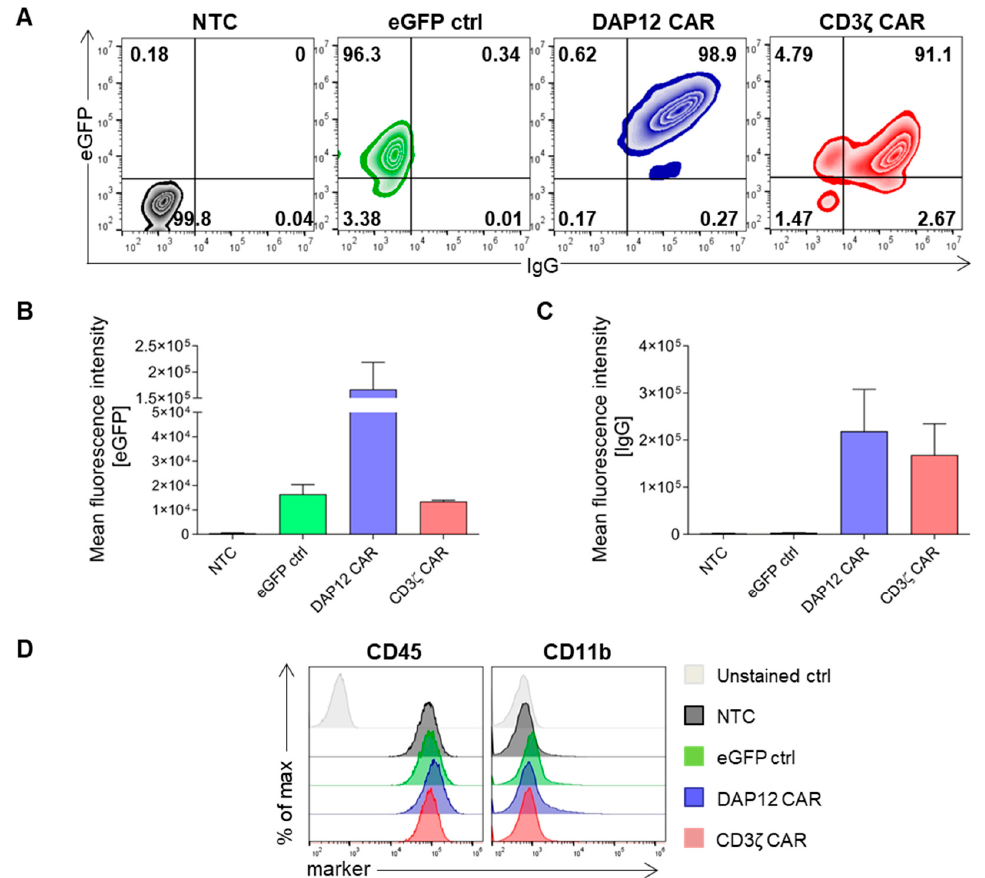
Figure A1. Assessment of CAR expression and characterization in MONO-MAC-6 cells. ( A ) Representative flow cytometric analyses of eGFP and CAR expression in MONO-MAC-6 cells transduced with eGFP alone (eGFP ctrl), the DAP12 CAR construct, or the CD3 ζ CAR construct. Mock-transduced cells (mock) were used as additional controls. Mean fluorescence intensity of ( B ) eGFP and ( C ) IgG expression in MONO-MAC-6 cells. Data ( A – C ) are represented as the mean ± s.e.m. of n = 2 biological replicates. ( D ) Flow cytometric analyses of M Φ surface markers ( n =